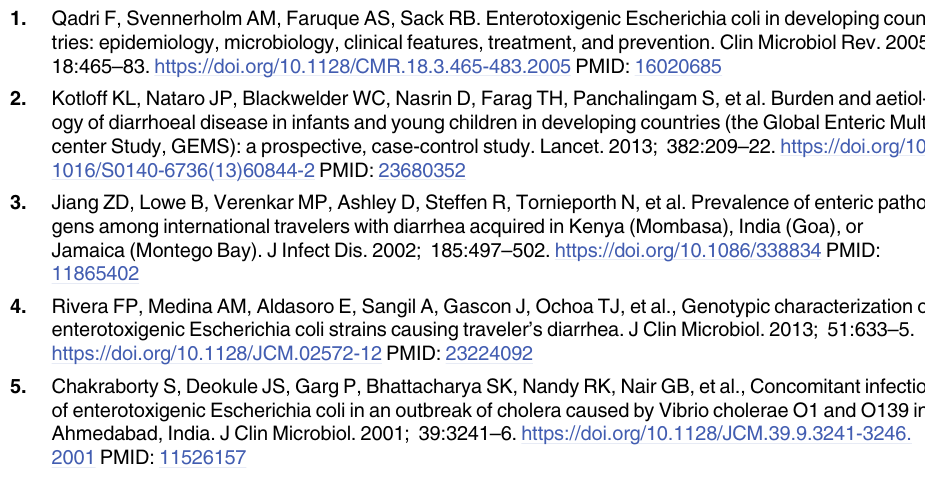
S2 Fig. Linearity of RLDT Time to result (TTR) corresponds to the concentrations of ETEC or Shigella. Stool samples spiked with serially diluted ETEC and Shigella strains were tested with RLDT kit. Linearity was established by the average of log TTR values against CFU/ gm of stool. Linear regression equation, Pearson correlation coefficient and p values are given in the